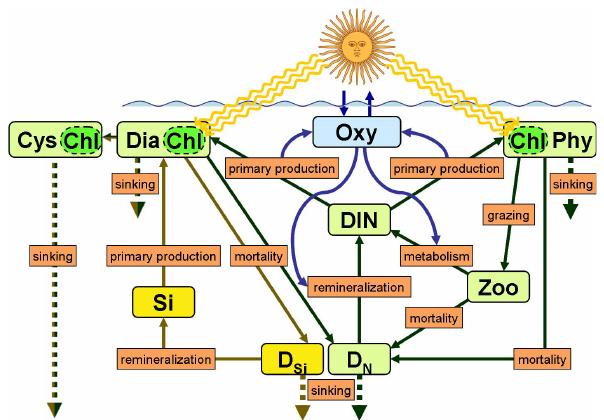
Fig. 2. Schematic of the 2p2s biological model. The 1p1s and 2p1s models are simplified variants of this